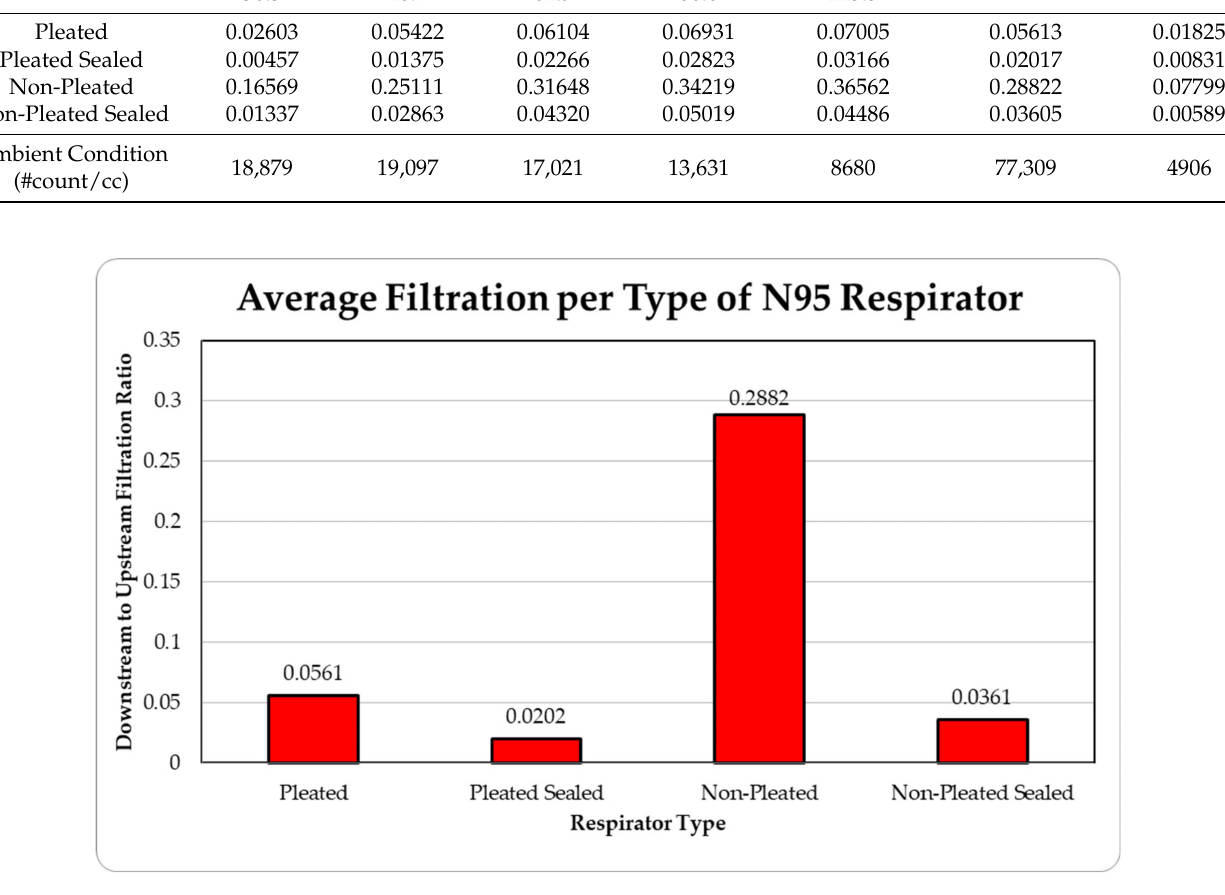
Figure 7. Average filtration ratios of total particles per type of respirator at the direct airflow from MIG Welding.